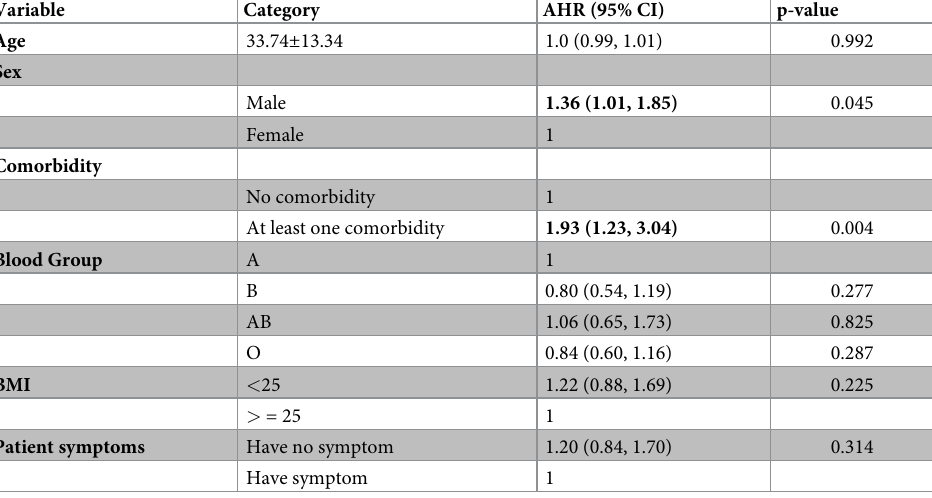
Table 3. Cox proportional hazards analysis of predictors of delayed recovery of patients with corona virus disease 2019 (n =